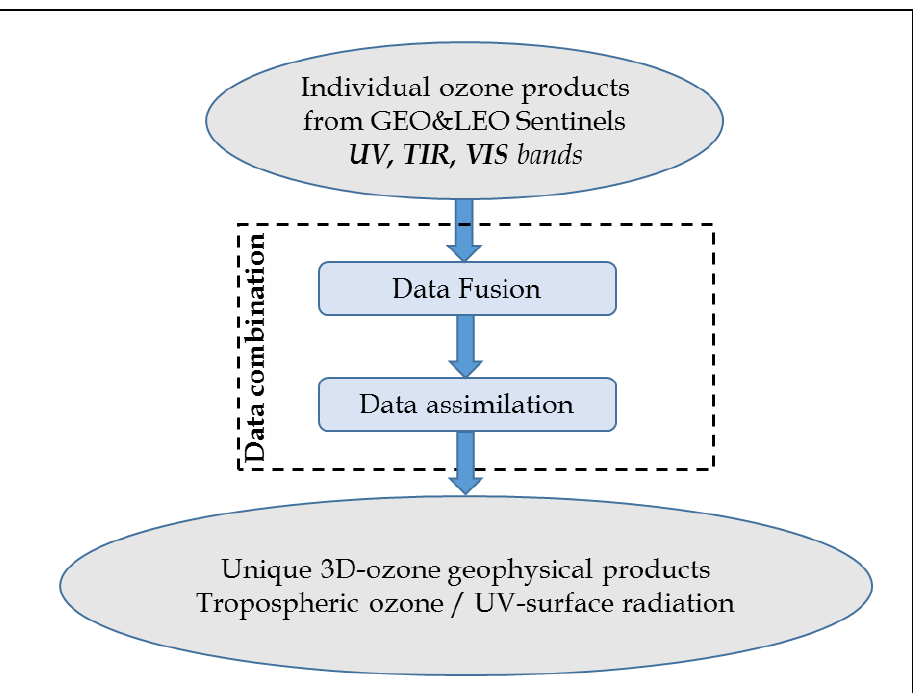
Figure 1. Two-stages approach used to combine the individual ozone products derived from UV, TIR and VIS bands, provided by both GEO and LEO